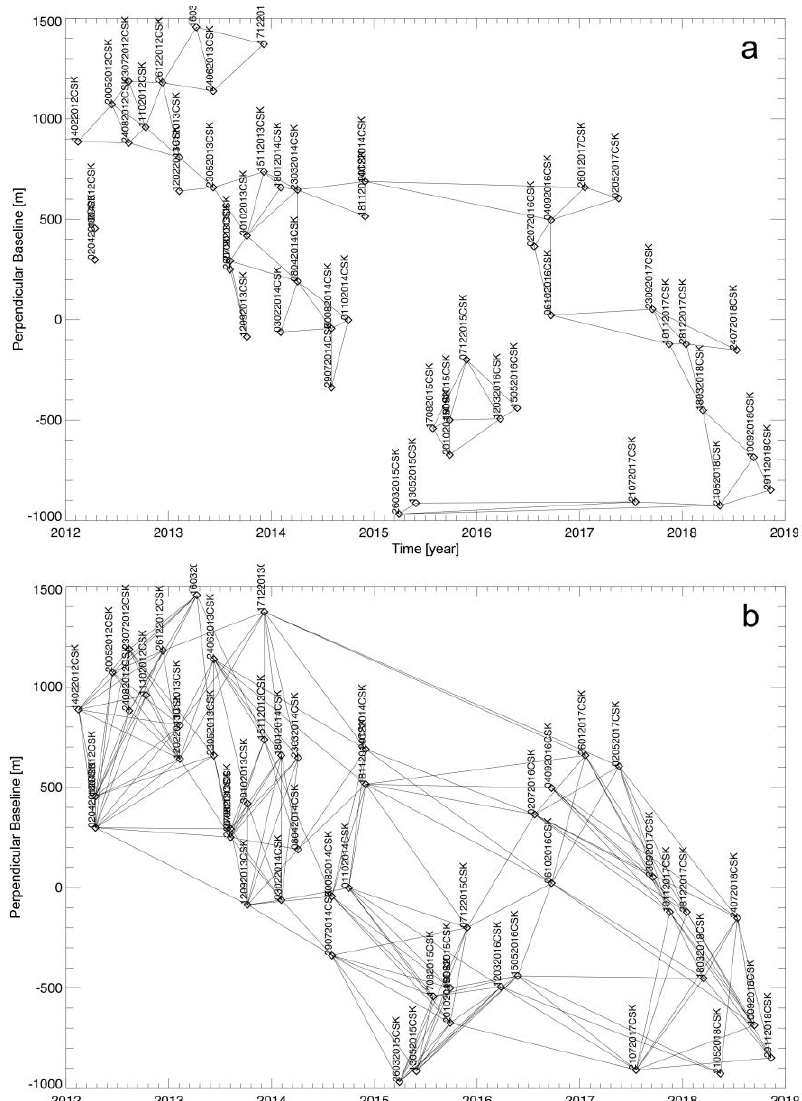
Figure 2. Interferometric SAR distributions in the temporal/perpendicular baseline plane. ( a ) The M 1 = M ( Tr ) interferometric data pairs of the (reduced) Delaunay triangulation used by the canonical EMCF PhU algorithm. ( b ) The additional M 2 = M − M 1 interferometric data pairs that are unwrapped using the modified EMCF PhU algorithm.